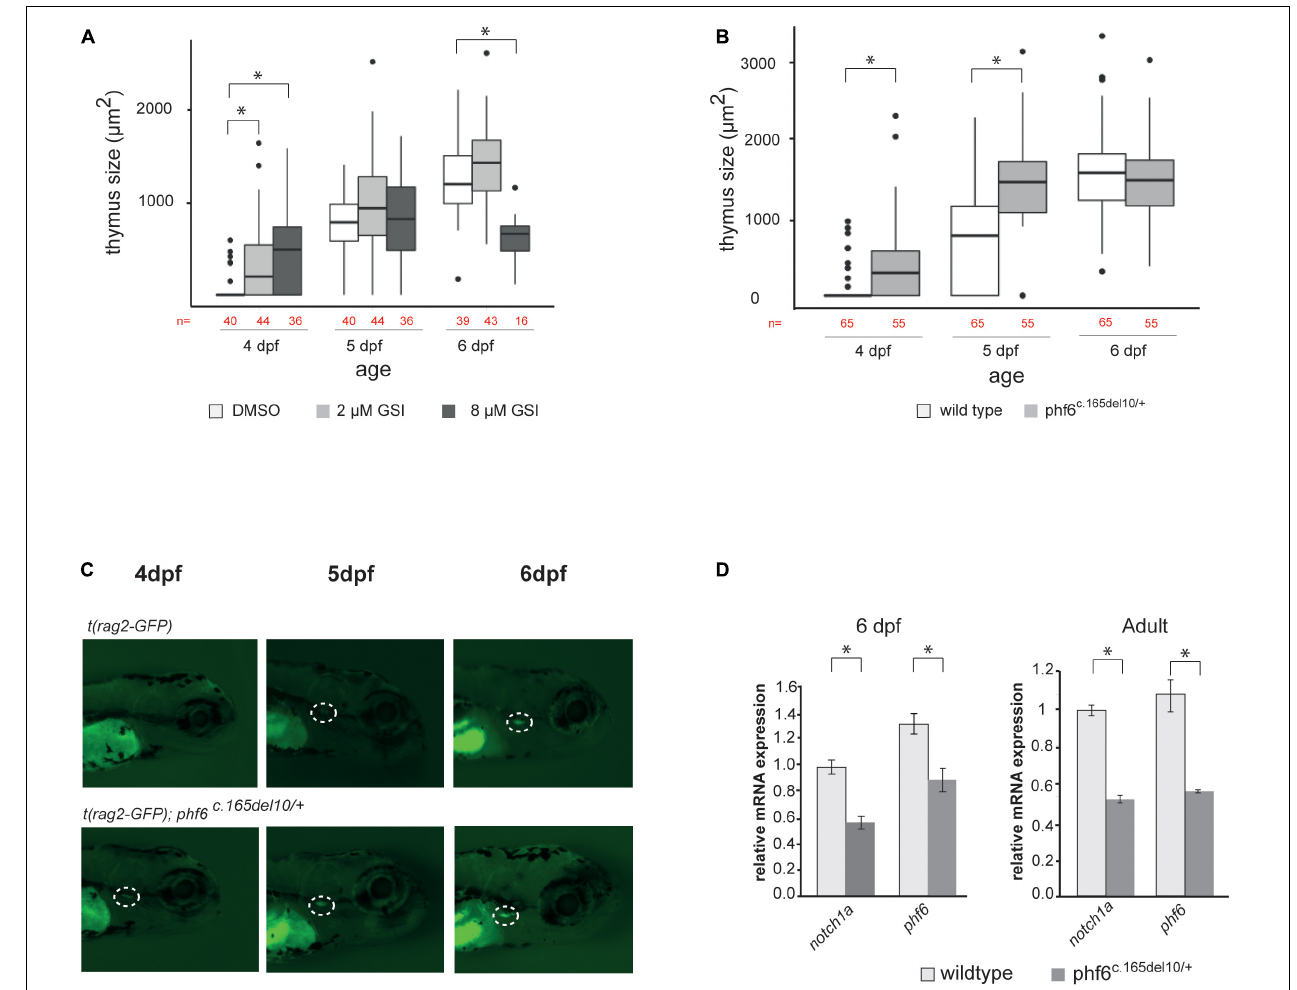
FIGURE 7 | phf6 downregulation accelerates T cell development in vivo . (A) Box plot showing thymus size ( µ m 2 ) at 4, 5, and 6 days post-fertilization (dpf) based on GFP signal of wild type (AB) fish treated with 2 or 8 µ M of gamma-secretase inhibitor (GSI) or DSMO as control treatment. Details on these results are provided in Supplementary Table 2 and statistical analysis is shown in Supplementary Table 3 , ∗ P < 0.05 (Wilcoxon rank sum test). (B) Boxplot showing thymus size ( µ m 2 ) of wild type (AB) and phf6 c . 165del10 / + heterozygous embryos from 4 until 6 dpf based on rag2-GFP signal quantification. ∗ P < 0.05 (Wilcoxon rank sum test, Supplementary Table 4 ). (C) Representative image of thymus visualization used for quantification of data as shown in panel (A). Original magnification X30. Circle with white dashed line indicates emerging thymus. (D) Average normalized notch1a and phf6 expression in sorted T cells of 4 replicates of 100 pooled wild type